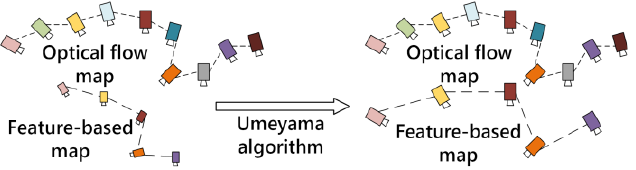
Figure 6. Illustration of the alignment process between optical flow map and feature-based map by using Umeyama algorithm.